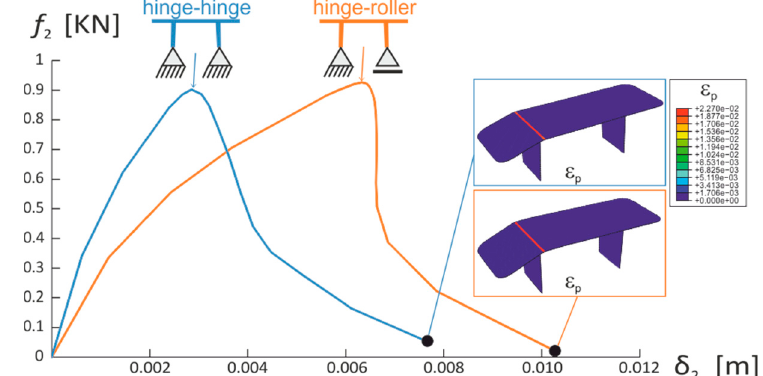
Figure 8. Lateral vertical loading. Force-displacements curves for different boundary conditions, and snapshots of plastic deformation at failure.